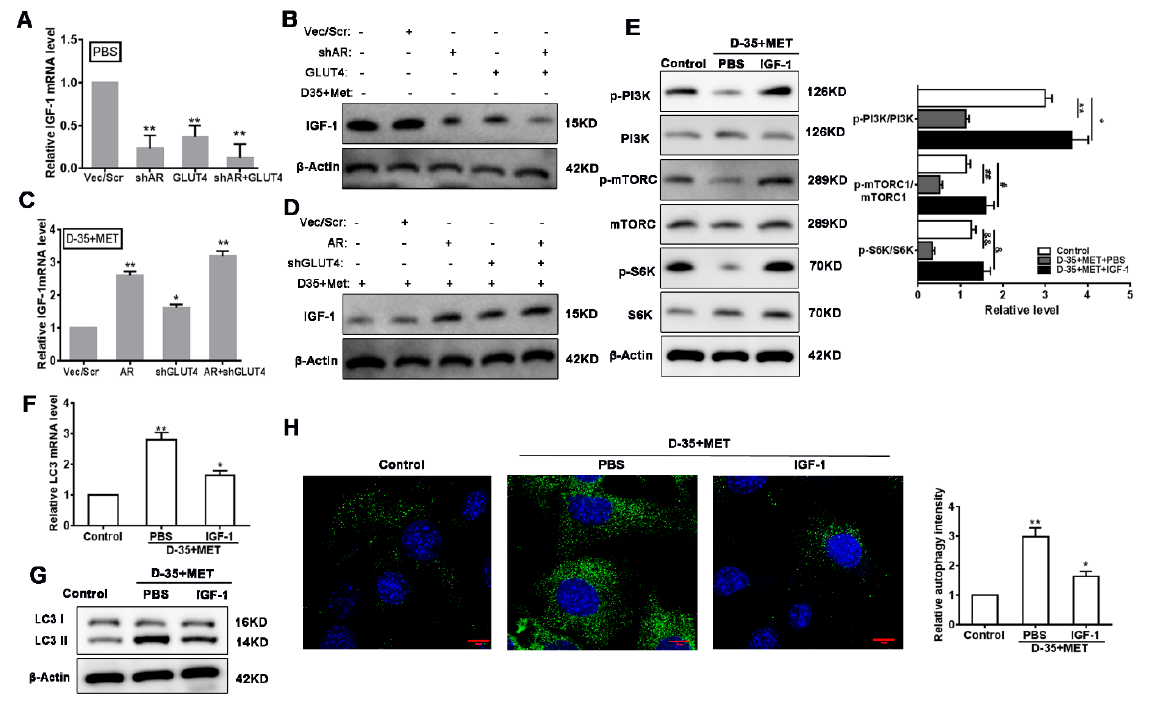
Figure 5. Autophagy is enhanced by inhibition of the IGF-1-mediated PI3K/mTORC1 pathway. IGF-1 expression level in Ishikawa cells with the transfection of different AR and GLUT4 expression vectors with or without Diane-35 and metformin treatment ( A – D ). Effects of Diane-35 and metformin (10 mM) on the expression of the PI3K, AKT, and mTORC1 pathways in Ishikawa cells with or without the addition of IGF-1 ( E ). Cell autophagy was measured using qRT-PCR ( F ), Western blotting ( G ), and immunofluorescence ( H ). Data are shown as the mean ± S.D. * p < 0.05, # p < 0.05, & p < 0.05 and ** p < 0.01, ## p < 0.01, && p < 0.01, ANOVA. Scale bars = 10 µ